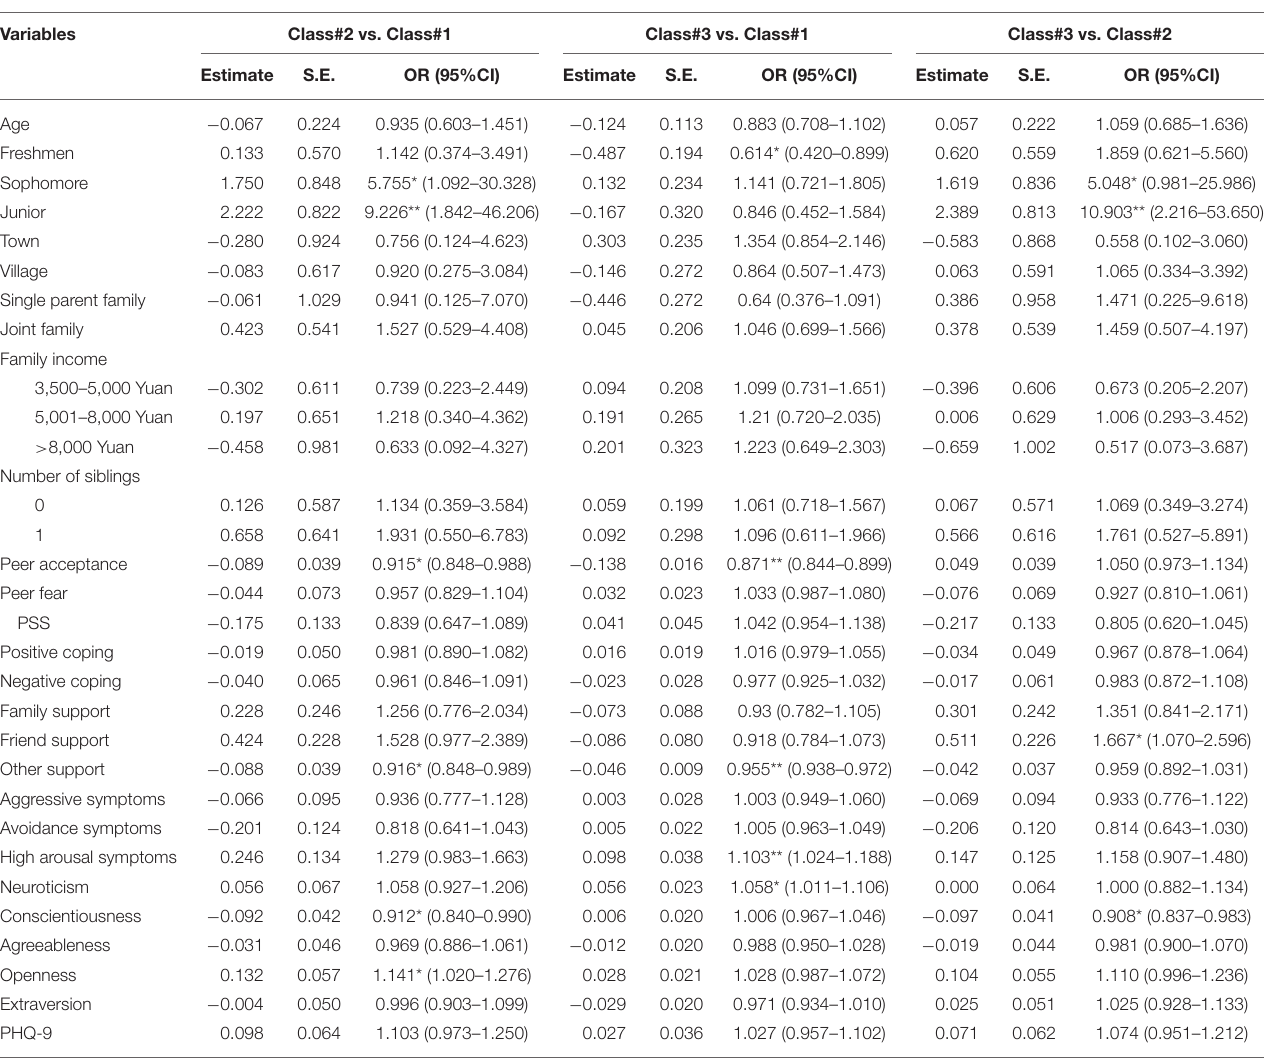
TABLE 4 | The differences in psychosocial variables between latent profile